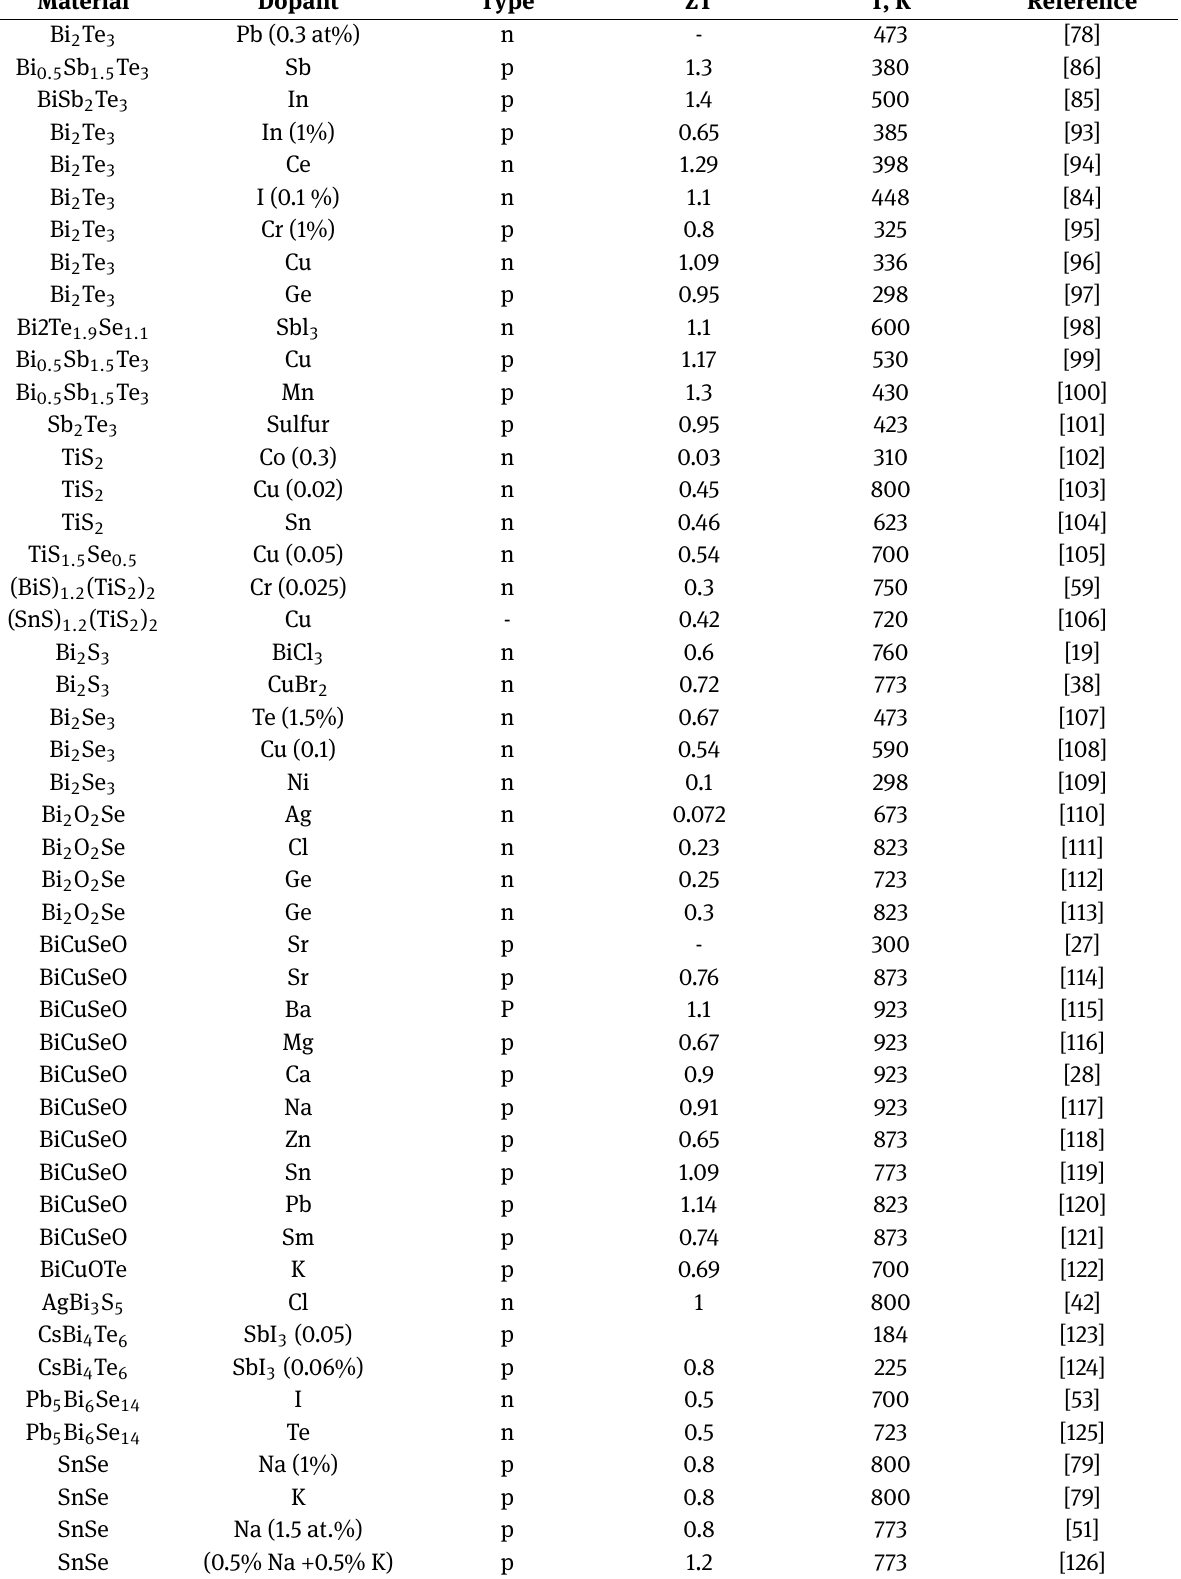
Table 2: ZT of doped layered chalcogenide